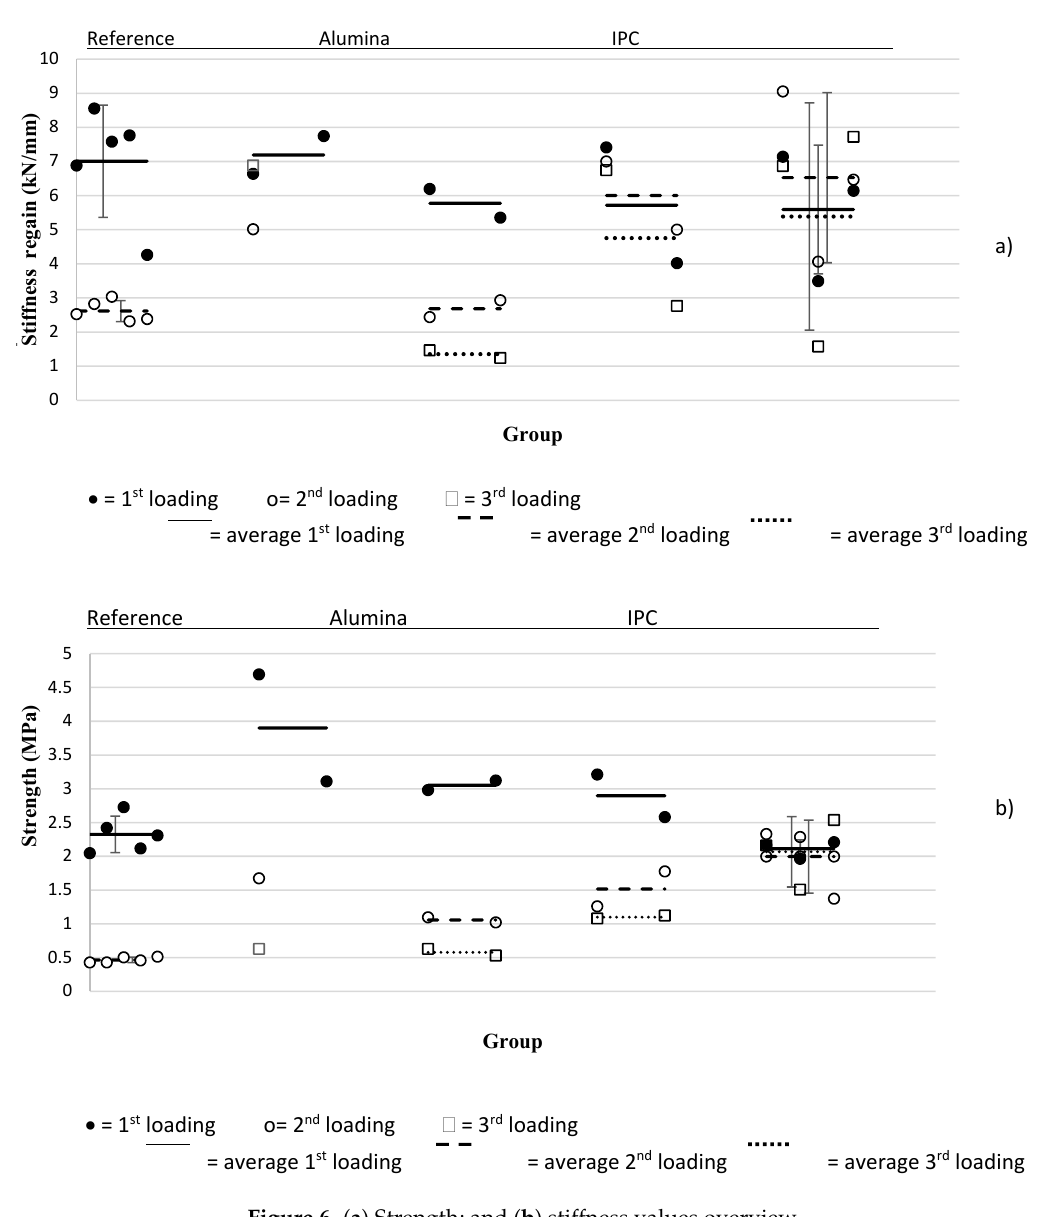
Figure 6. ( a ) Strength; and ( b ) stiffness values overview.